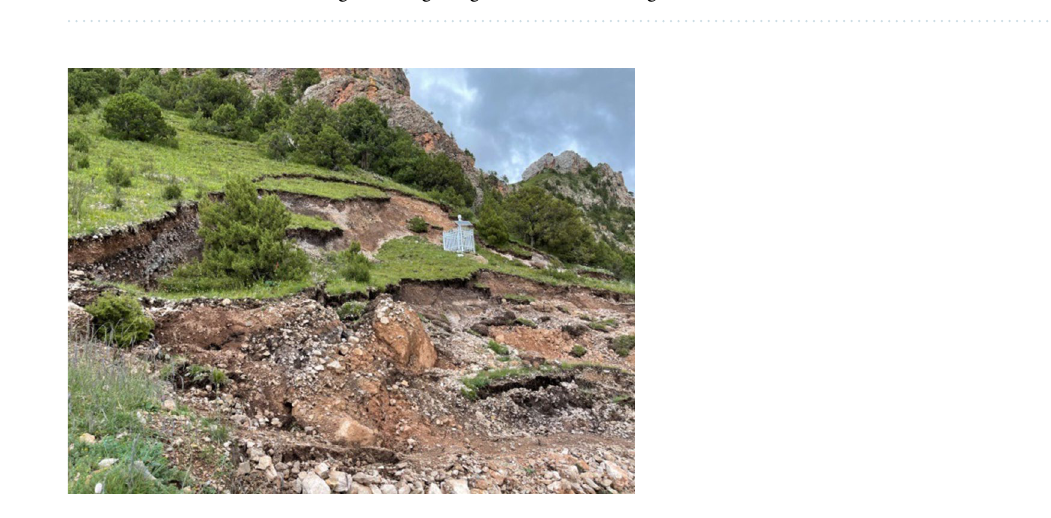
Figure 3. Geological profile (this figure is taken from 7 references: <China Geological Survey, Ministry of land and resources. Detailed investigation of geological hazards in Qinghai>).